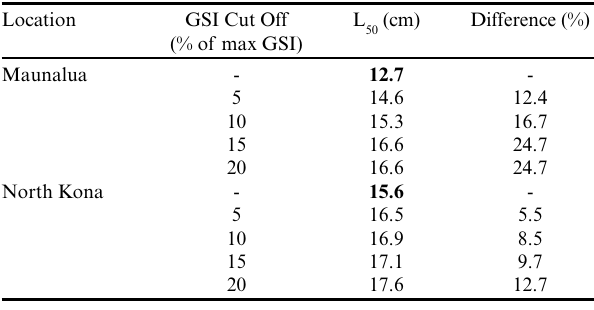
Table 3 . Results from 5, 10, 15, and 20% of maximum gonadosomatic index (GSI) used to assess size at maturity for manini (convict tang, Acanthurus triostegus sandvicensis ) from Maunalua Bay (Oahu) and North Kona (Hawai ʻ i). Histological size at maturity for each location is bolded and compared to each GSI percentage cutoff to assess differences between GSI and histologically assessed size at maturity (L 50